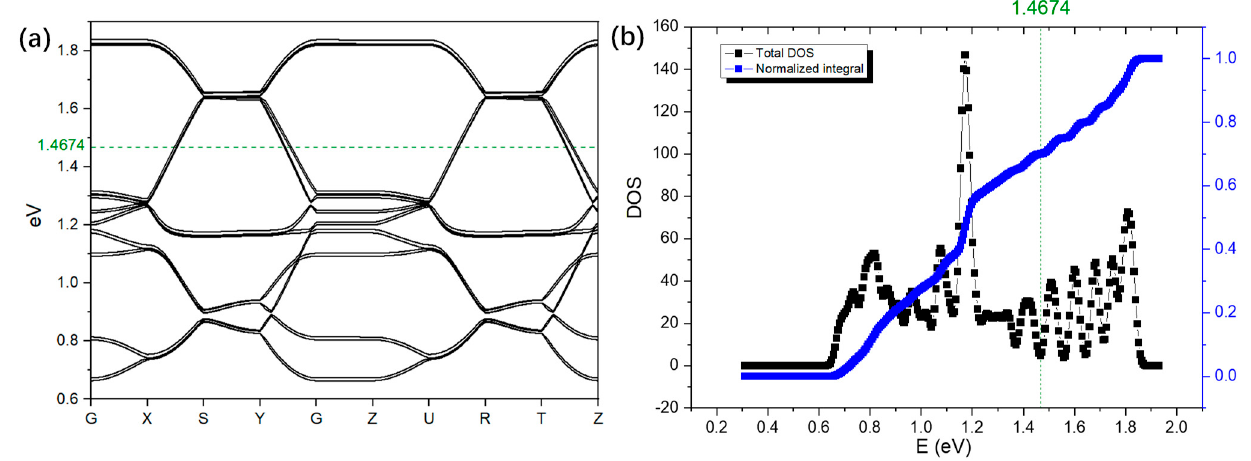
Figure 7. ( a ) The band structure of compound 1 . The corresponding Fermi level is represented by the green dash line. G (0, 0, 0); X (0.5, 0, 0); Y (0, 0.5, 0); Z (0, 0, 0.5); S (0.5, 0.5, 0); U (0.5, 0, 0.5); T (0, 0.5, 0.5); R (0.5, 0.5, 0.5). ( b ) Density of states (DOS) of compound 1 .